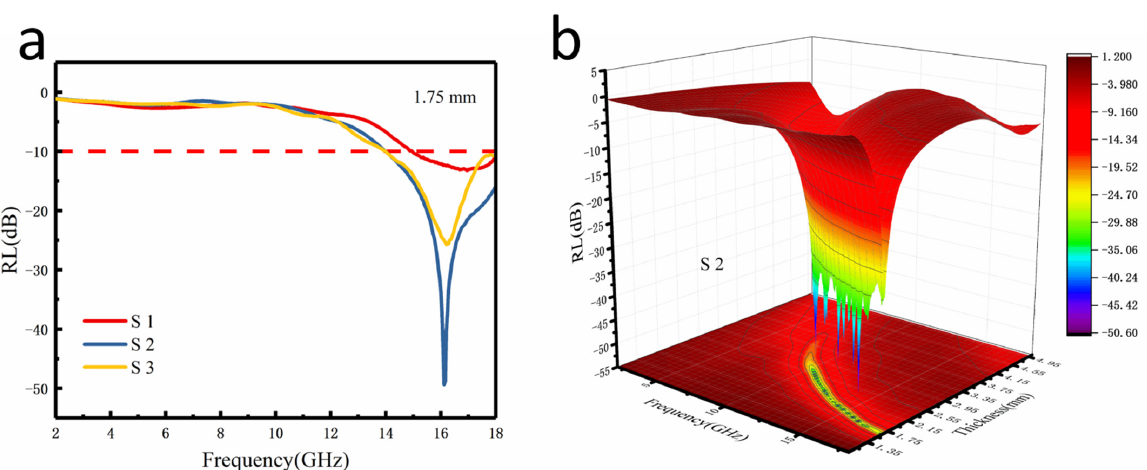
Figure 4. ( a ) Frequency-dependent reflection loss curves of S1, S2, and S3. ( b ) 3D representation of reflection-loss values of S2.